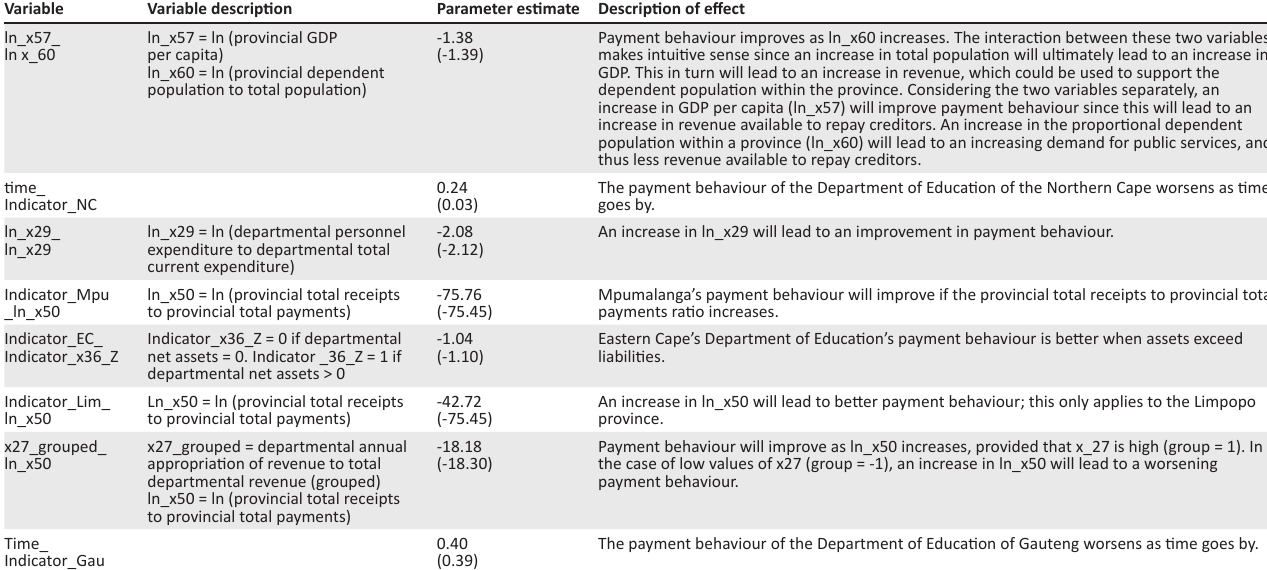
TABLE 6: Details of the Advanced Models (Education Advanced Model 1 [Model 2]), specifically developed for the Department of Education. Variable Variable description Parameter estimate Description of